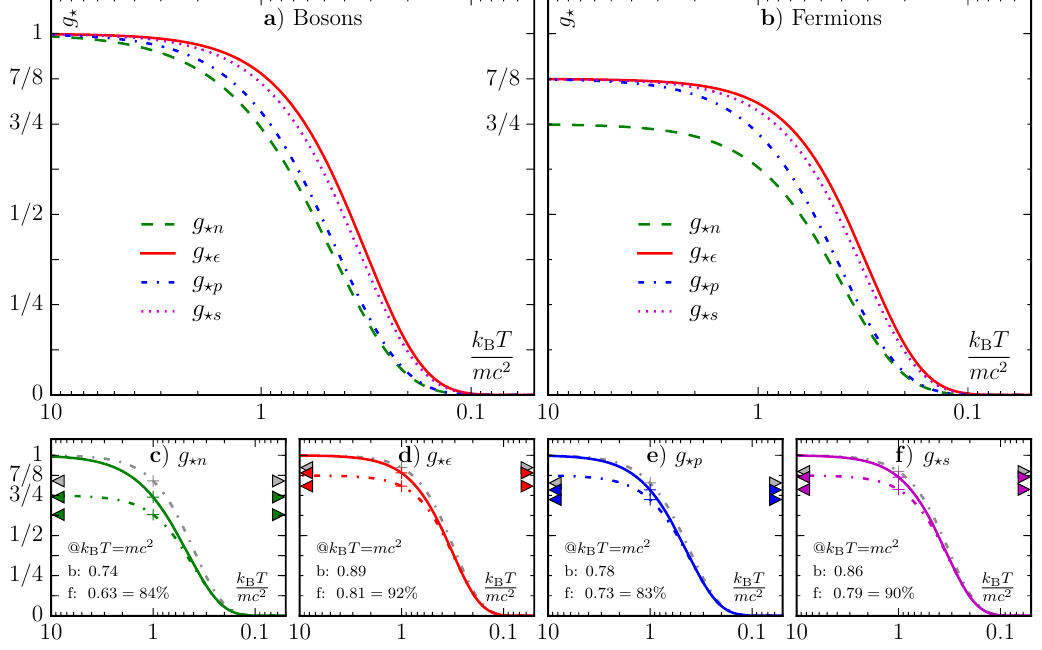
Figure 3. The effective degrees of freedom g ⋆ n , g ⋆ (cid:101) , g ⋆ p , and g ⋆ s for bosons ( a ) and fermions ( b ) per intrinsic degree of freedom. A more detailed look at each of the four g ⋆ s is given in the lower four panels ( c – f ). Here the solid colored curves are for the bosons, and the dash-dotted colored curves are for the fermions. The grey dash-dotted curves represent the fermions’ contribution compared to its own relativistic value (such that it is 100% for T → ∞ ). We have included the relative values at k B T = mc 2 for the four cases (marked with “+” symbols). During particle annihilations, the energy density falls slower than the other quantities due to the impact of the rest mass energy. At temperatures close to the rest mass of some massive particle species, this rest mass is substantial to their total